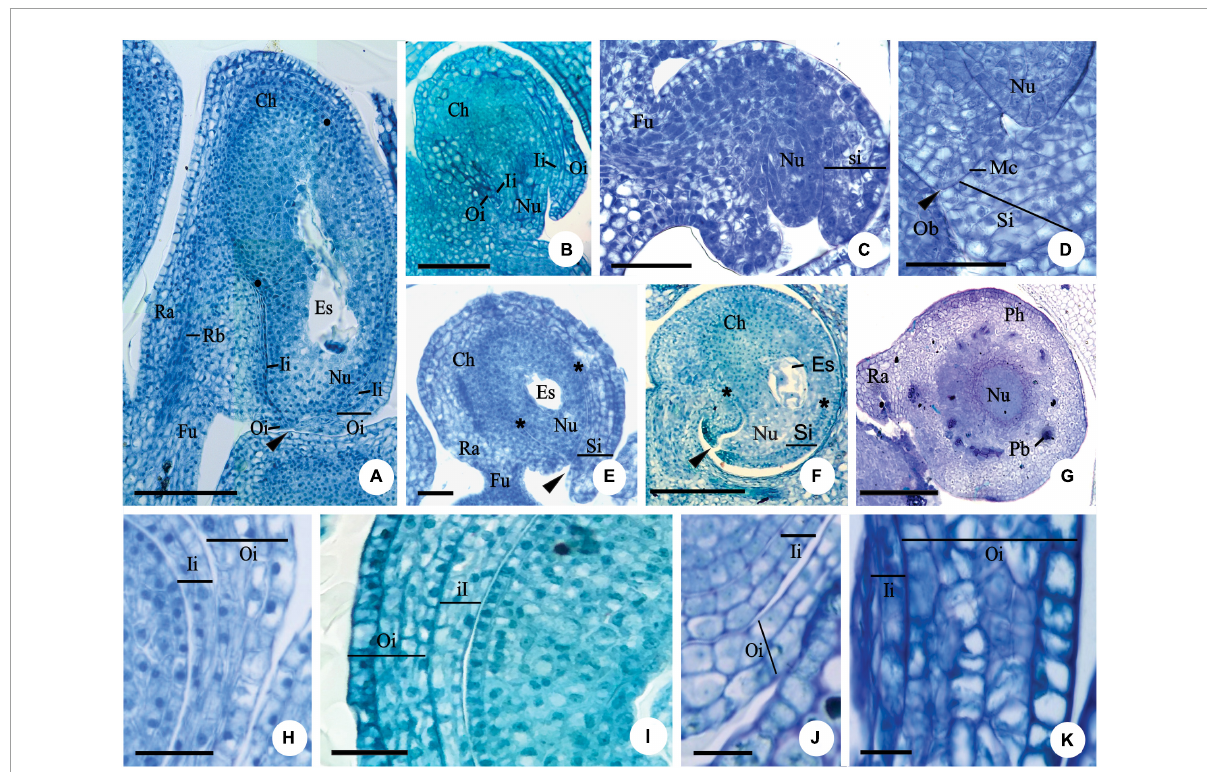
FIGURE1 Longitudinal (A–F,H–I,K) and transversal (G,J) sections of the ovule of flower buds (B,C) , flowers at anthesis (A,E–K) and post-anthesis (D) of Myrcianthes pungens (A,H) ; Eugenia neoverrucosa (B) ; E. uniflora (C–E) ; E. florida (F) ; Eugenia arenosa (G) ; E. myrciantes (I) ; E. hiemalis (J) and E. longipedunculata (K) . (A) Bitegmic and anatrapous tending to campylotropus ovule and perichalaza ( • ) beginning its differentiation. (B) Campylotropus ovule evidencing the integuments development. (C–E) Development of the campylotropous and unitegmic ovule. Note in photo (C) the development of the single integument; in photo (D) an obturator in contact to the mycropyle; and in photo (E) the pachychalaza (*). (F) Campylotropous and unitegmic ovule. Note the extensive pachychalaza and the single integument restricted to the vicinity of the micropyle. (G) Ovule showing the ramification of the rapheal bundle in the pachychalazal integument. (H–K) Details evidencing the integument layers. Ca, chalaza; Es, embryo sac; Fu, funicle; Ii, inner integument; Mc, micropylar channel; Nu, nucellus; Ob, obturator; Oi, outer integument; Pb, pachychalazal vascular bundle; Pc, pachychalaza; Ra, raphe; Rb, rapheal bundle; Si, single integument; (cid:73) , micropyle. Scale bars: 25 µ m (C,D,H,J,K) , 50 µ m (A,E) , 100 µ m (B,I) , 200 µ m (F,G) .